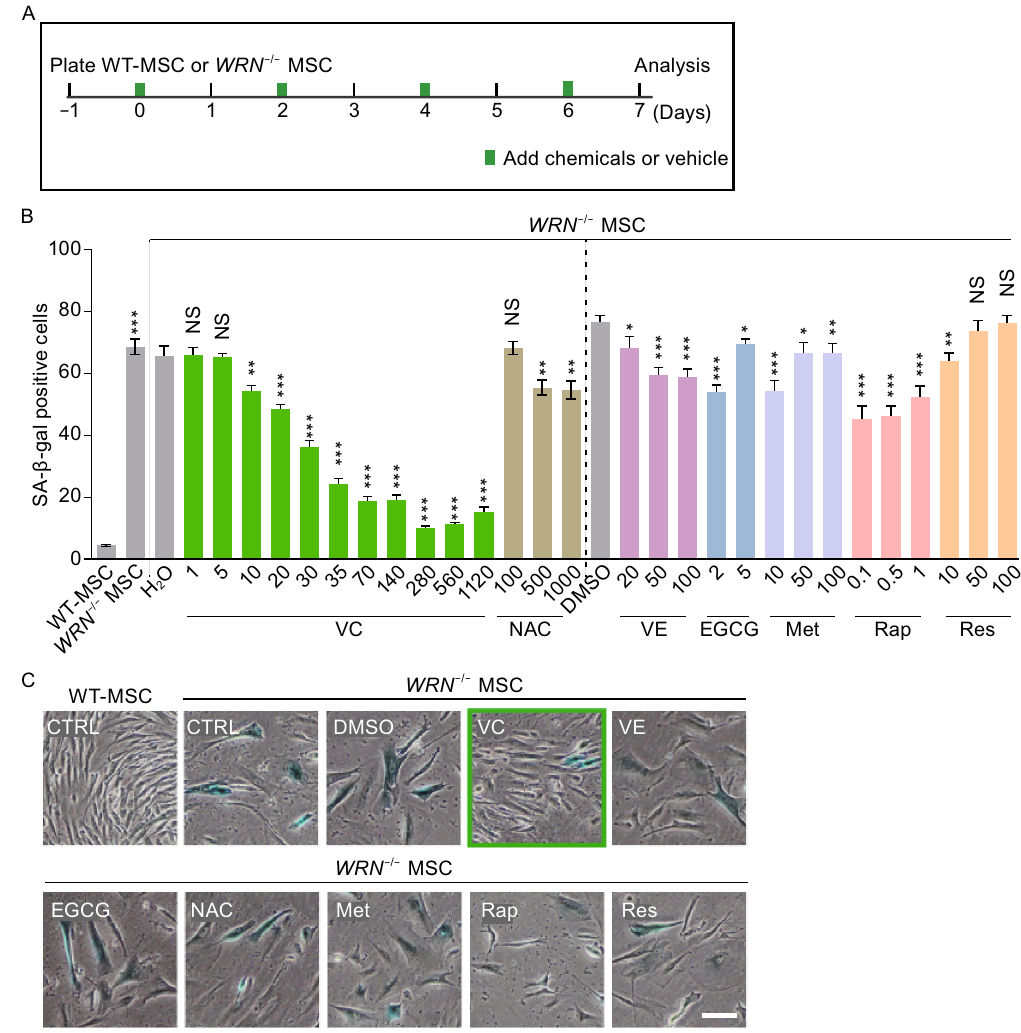
Figure 1. Chemicals screening for alleviating premature aging in WS MSCs. (A) Schematic demonstration of the chemical screening protocol. 3 × 10 4 wild-type (WT) or WRN -/- MSCs (P5) were seeded in one well of 6-well dish, following with the treatment with the chemicals or vehicle control (water or DMSO) and refreshed every other day. Cell senescence, assayed by senescence associated β -galactosidase (SA- β -gal) staining, was analyzed 1 week later. (B) Frequency of SA- β -gal positive cells in WTor WRN -/- MSCs with or without chemical treatment. For each molecule, different concentrations were used as indicated along the X axis. Data are represented as mean ± SEM, * P < 0.05, ** P < 0.01, *** P < 0.001, NS, not signi fi cant by t test; n ≥ 3. (C) Representative images of SA- β -gal staining. VC: 280 µmol/L; VE: 20 µmol/L; EGCG: 2 µmol/L; NAC: 100 µmol/L; Met: 10 µmol/L; Rap: 0.1 µmol/L; Res: 10 µmol/L. Scale bar,